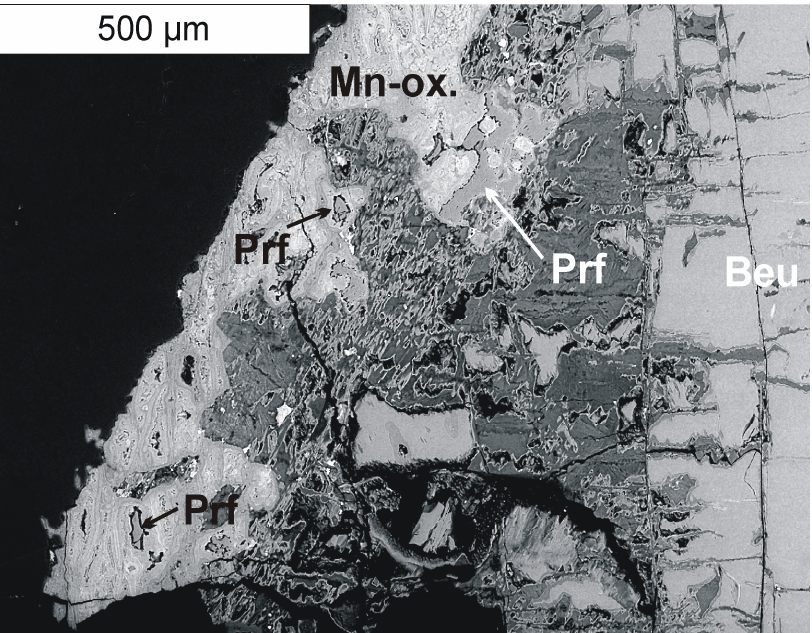
Figure 1. Parafiniukite as relict grains within the Mn-oxide; smectite matrix, around beusite. Holotype specimen MMWrIV8024. Labels: Beu = beusite; Mn-ox. = Mn-oxides; Prf = parafiniukite.